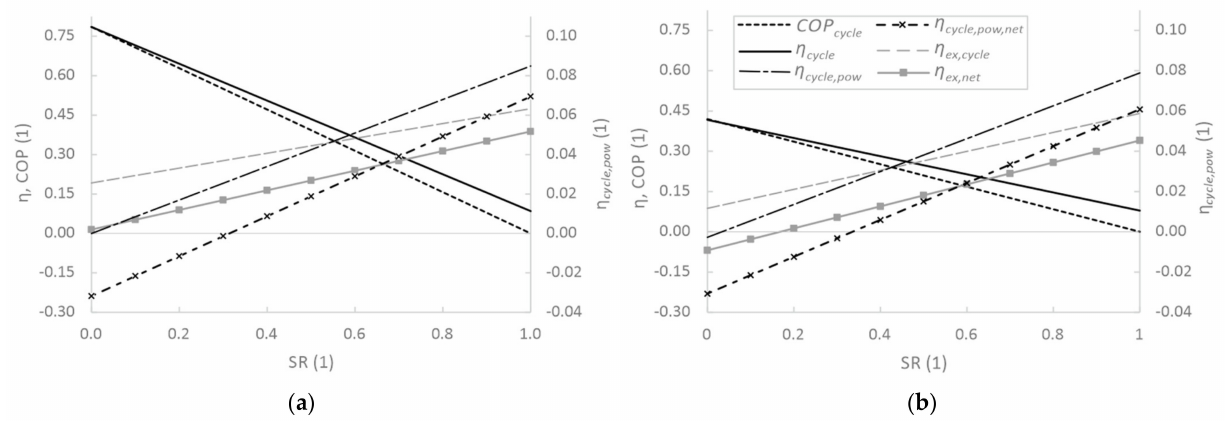
Figure 5. Sensitivity analysis of cycle performance with respect to the splitting ratio for APCC ( a ) and ORC–VCC ( b